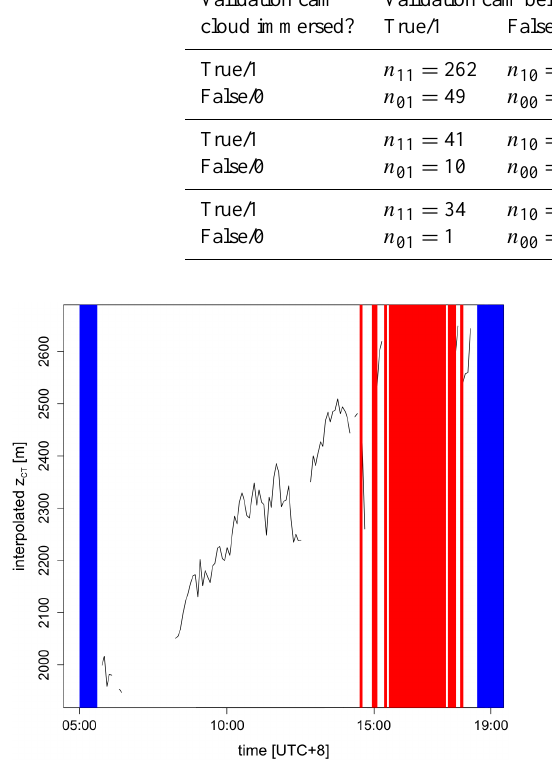
Figure 14. Increase in the cloud top height on 15 March 2013 for the position marked as “valley center” in Fig. 13.